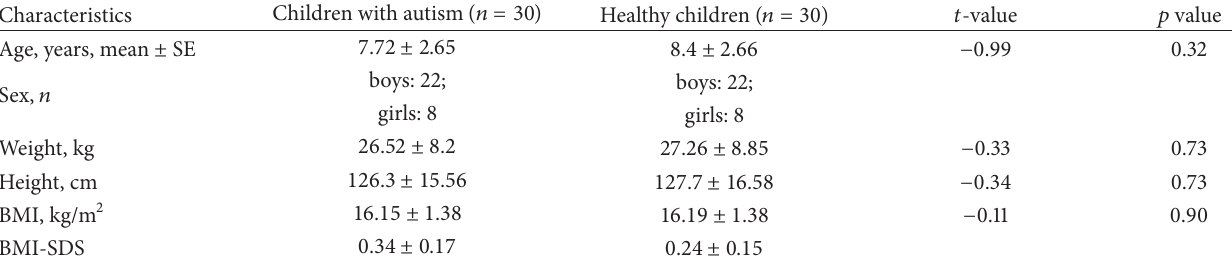
Table 1: Demographic and clinical characteristics of autistic children and healthy children.